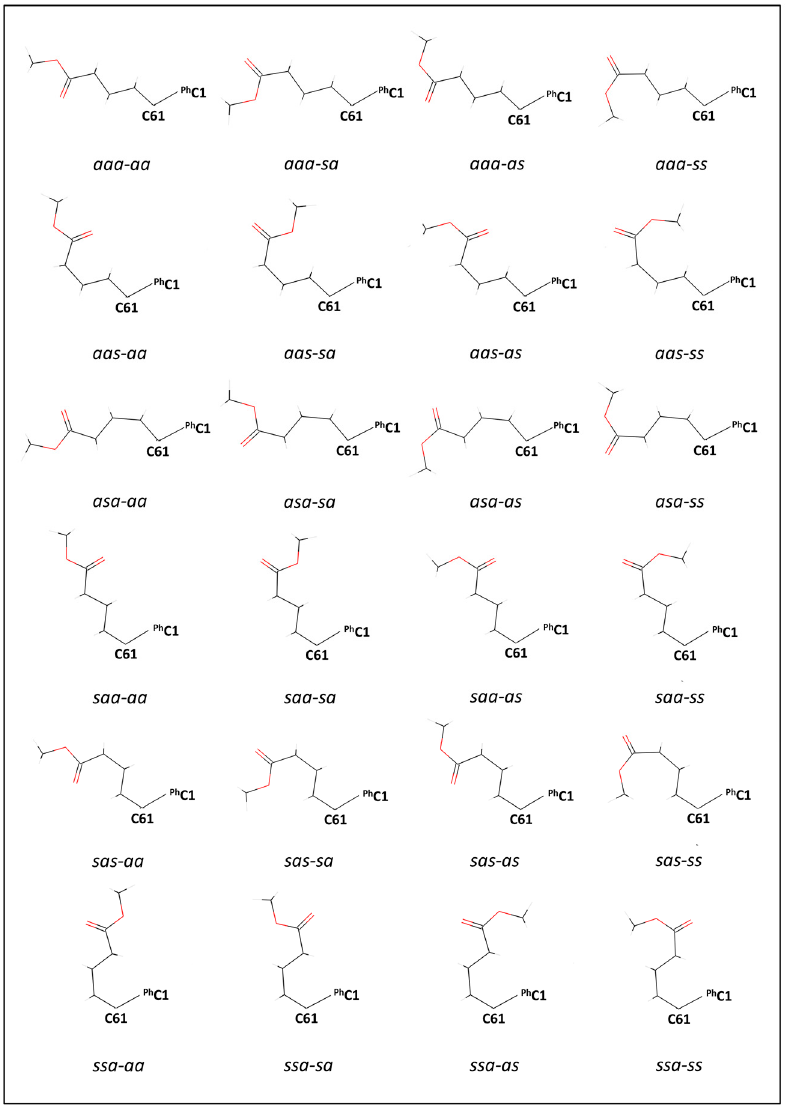
Figure 2. The 24 possible conformers of [60]PCBM. For clarity, the structures of the phenyl and cyclopropafullerenyl groups are not shown as they are invariant for all conformers. The ester group is shown at its C S ‐ constrained B3LYP/cc ‐ pVTZ optimised geometry for each conformer. It is apparent from inspecting Figure 2 that many of the bond angles are unrealistic.